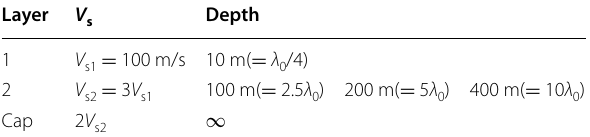
2 V , density 2.0 g/cm 3 ) p = s =